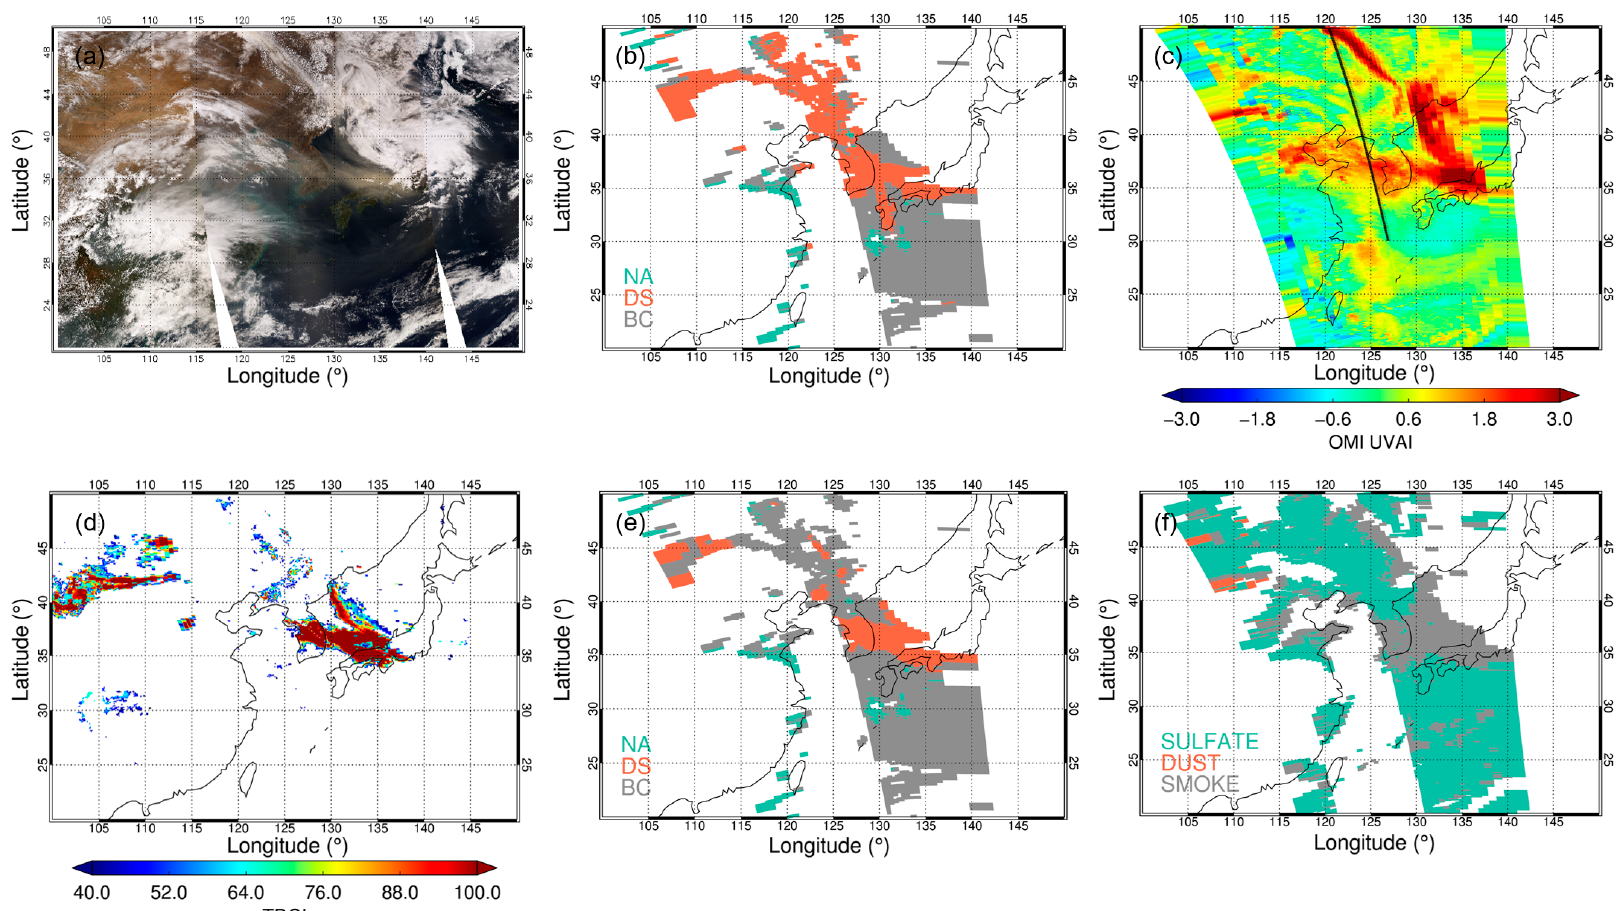
Figure 5. ( a ) MODIS RGB images for 8 April 2006, for the dust outbreak case; ( b ) GEMS aerosol type distinguished with ultraviolet (UV) aerosol index (UVAI) and visible aerosol index (VISAI) (fine pollution particles (BC), dust (DS), and non-absorbing (NA)); ( c ) OMI UVAI; ( d ) total dust confidence index (TDCI) calculated with MODIS; ( e ) GEMS aerosol type corrected with TDCI; ( f ) OMI aerosol type from operational (OMAERUV) products. OMI aerosol types ‘SMOKE’, ‘DUST’, and ‘SULFATE’ in ( f ) may correspond to ‘BC’, ‘DS’, and ‘NA’ aerosol types in GEMS ( b , e ), respectively.